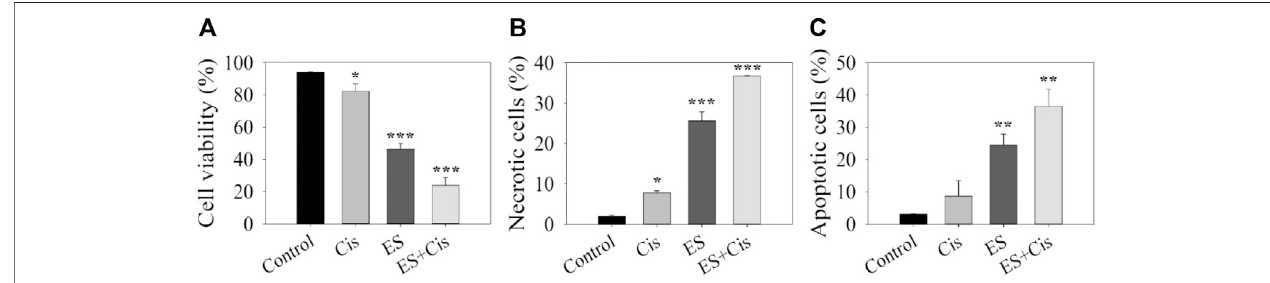
FIGURE 4 | Gating strategy for annexin V/PI staining for invitro experiment. Control cells (A) , Cispatin treatment (B) , electrospray only (C) , electrospray mediated Cisplatin (D) .